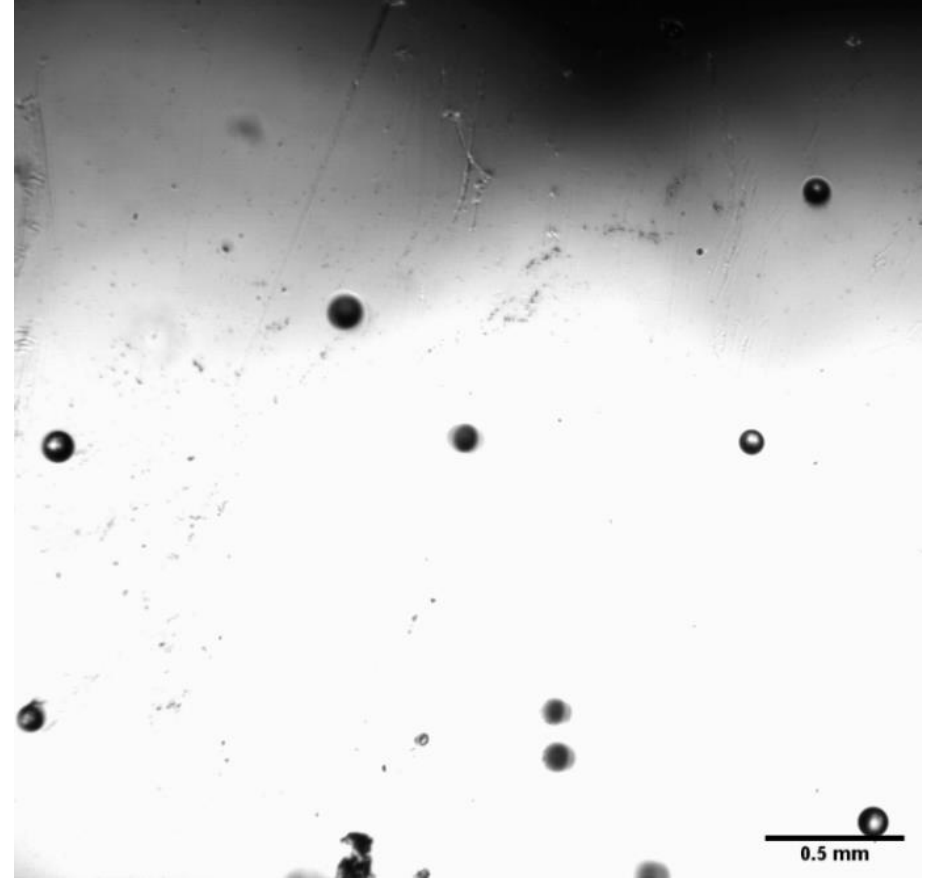
Figure 4. Representative bubbles.